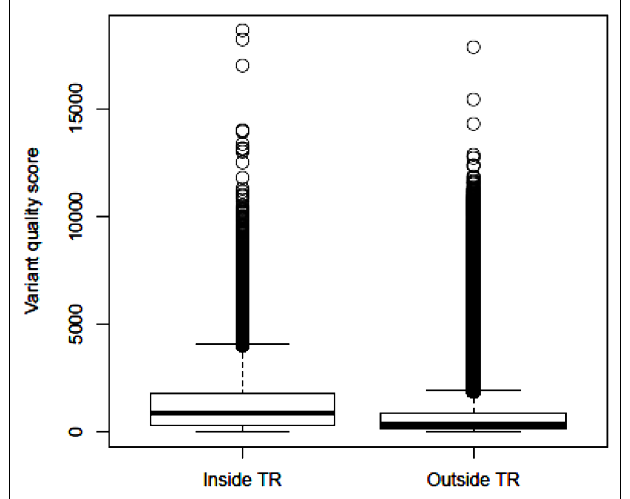
FIGURE 2 | Boxplot of identified variant quality scores inside the target regions and outside the target regions.